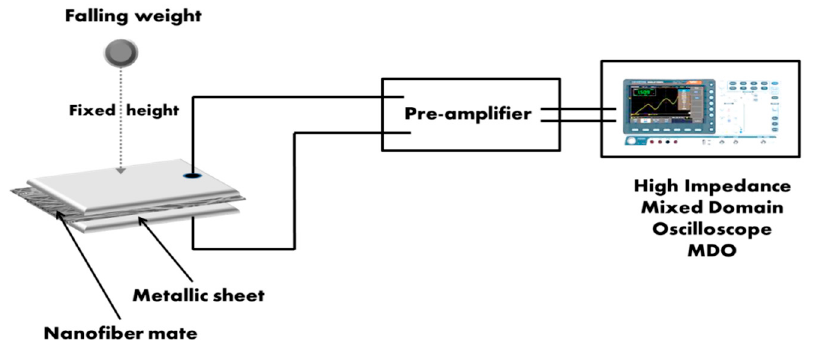
Figure 2. Schematic of impulse loading set-up.